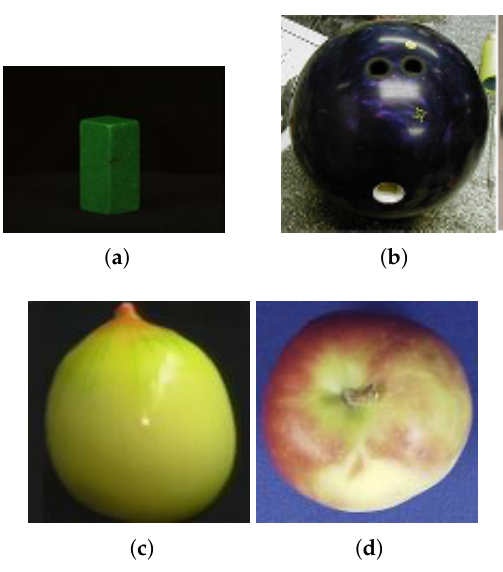
Figure 5. Dataset images: ( a ) ALOI, ( b ) Caltech 101, ( c ) COIL-100, and ( d ) ETH-80. Table 10. Results on the ALOI dataset. BoAW, Bag of ARSRG Words; BoVW, Bag of Visual Words. Method